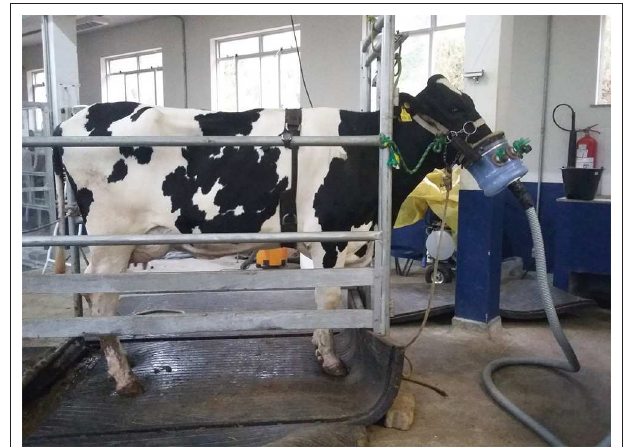
FIGURE 1 | Galvanized iron frame for animal restraint, and face-mask construction and application for the estimation of daily CH 4 methane production in cattle. Cow is also fitted with a heart rate